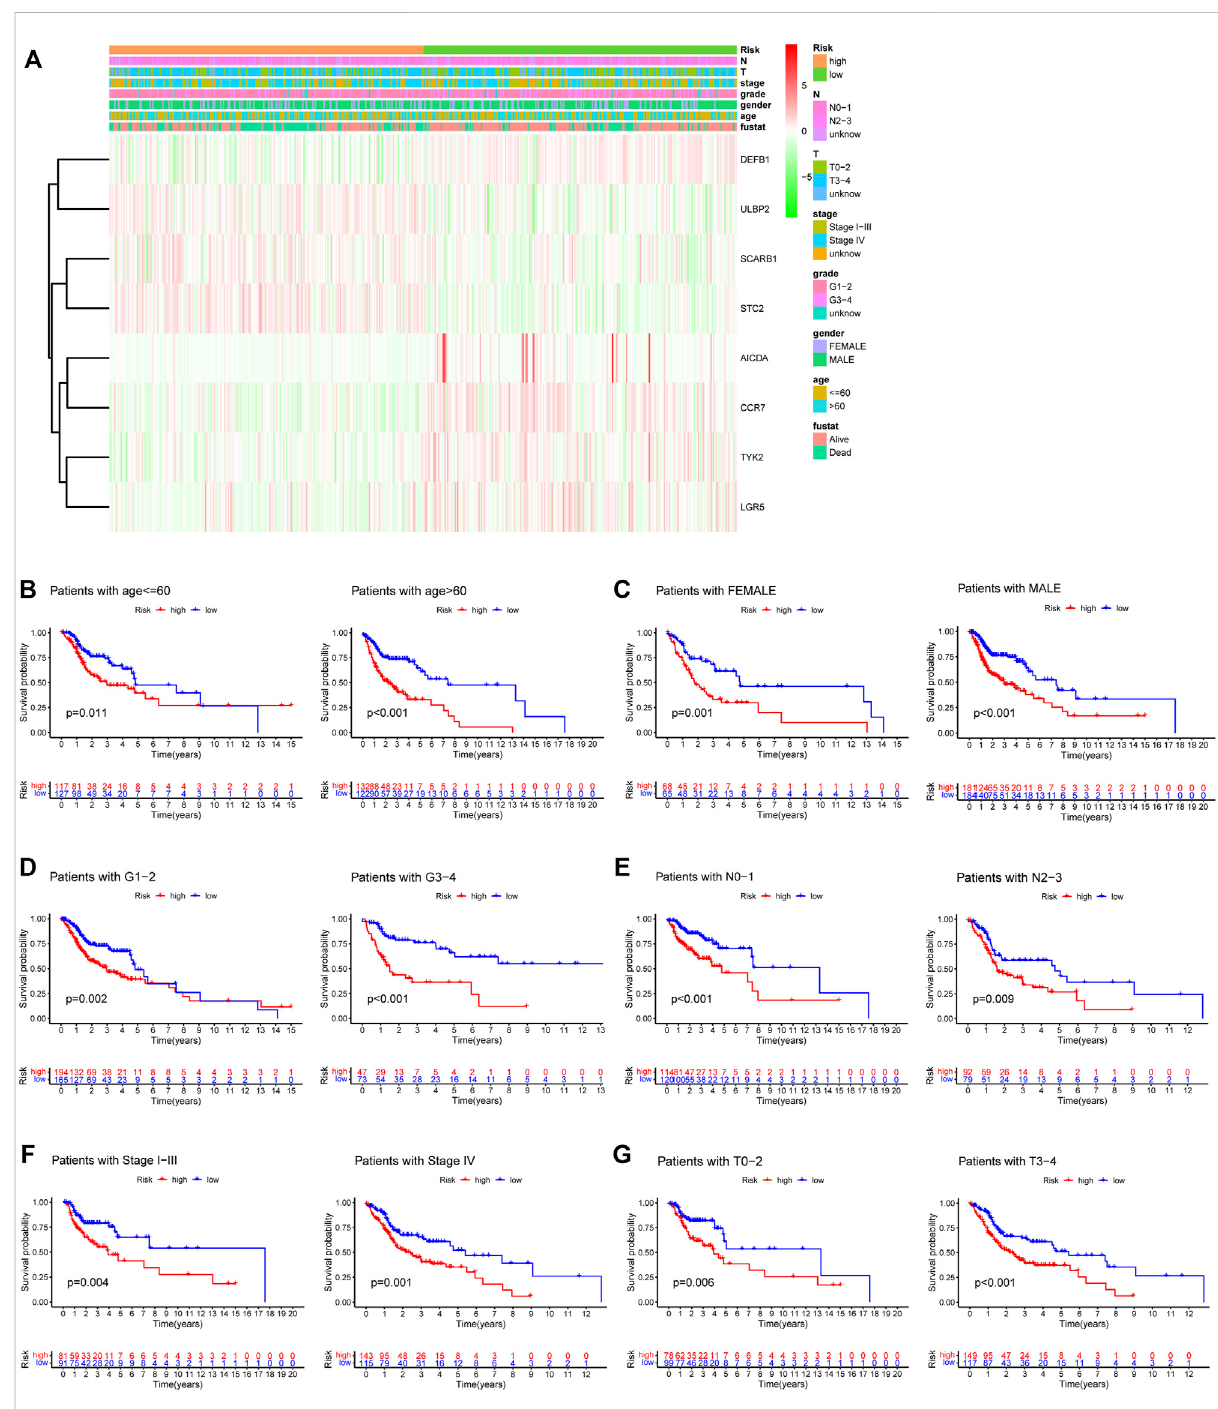
FIGURE 10 The relationship between risk signature and the clinical characteristics. (A) The heatmap depicting eight gene expressions among distinct clinical patterns. (B – G) Kaplan-Meier survival analysis according to the 8-gene signature strati fi ed by clinicopathological factors. (B) age < =60: p = 0.011, age > 60: p < 0.001. (C) Female: p =0.001,Male: p < 0.001. (D) G1-2: p =0.002,G3-4: p < 0.001. (E) N0-1: p < 0.001, N2-3: p =0.009. (F) Stage I-III: p = 0.004, Stage IV: p = 0.001. (G) T0-2: p = 0.006, T3-4: p <